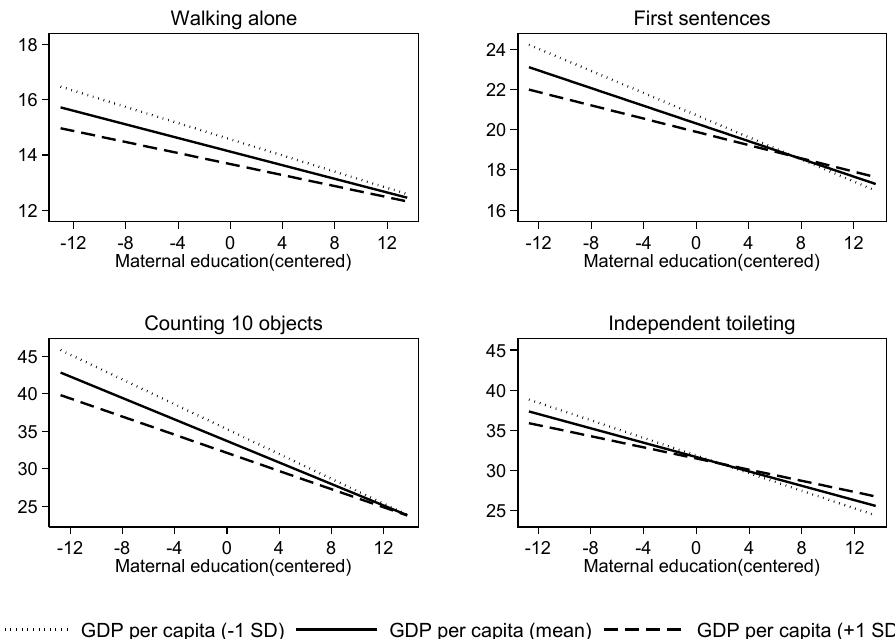
Figure 1. Predicted age of attainment of development milestones with maternal education as a function of county-level GDP per capita.